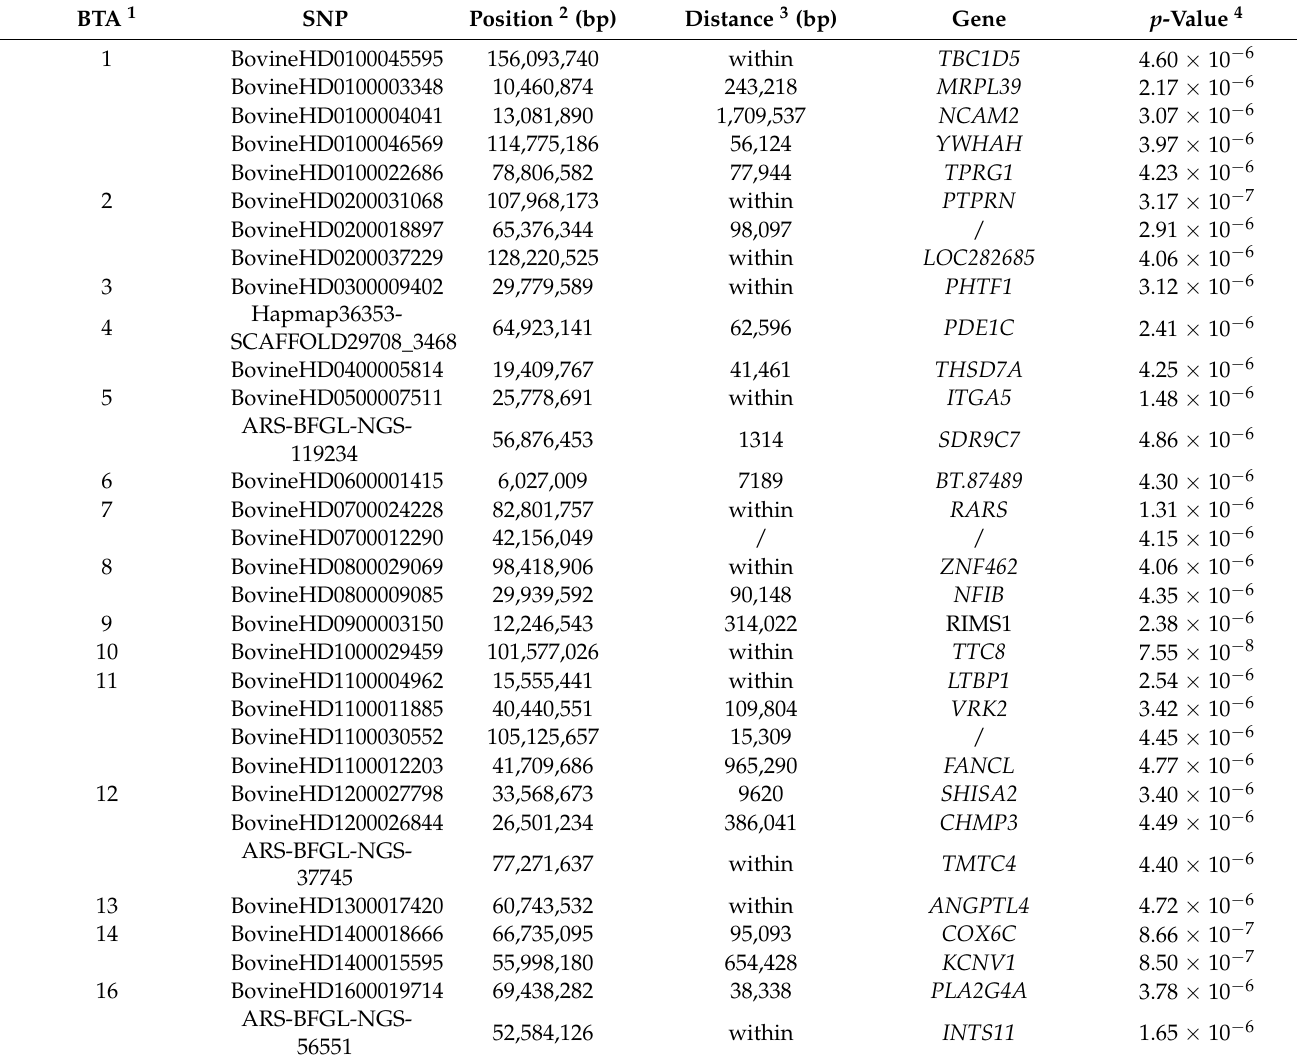
Figure 3. Manhattan plot of GWAS based on the random regression model. The horizontal axis shows the chromosomal position of the SNPs associated with body weight. The vertical axis indicates the absolute value of the − log 10 ( p ) of individual SNPs. Table 1. The detected candidate genes affecting body weight